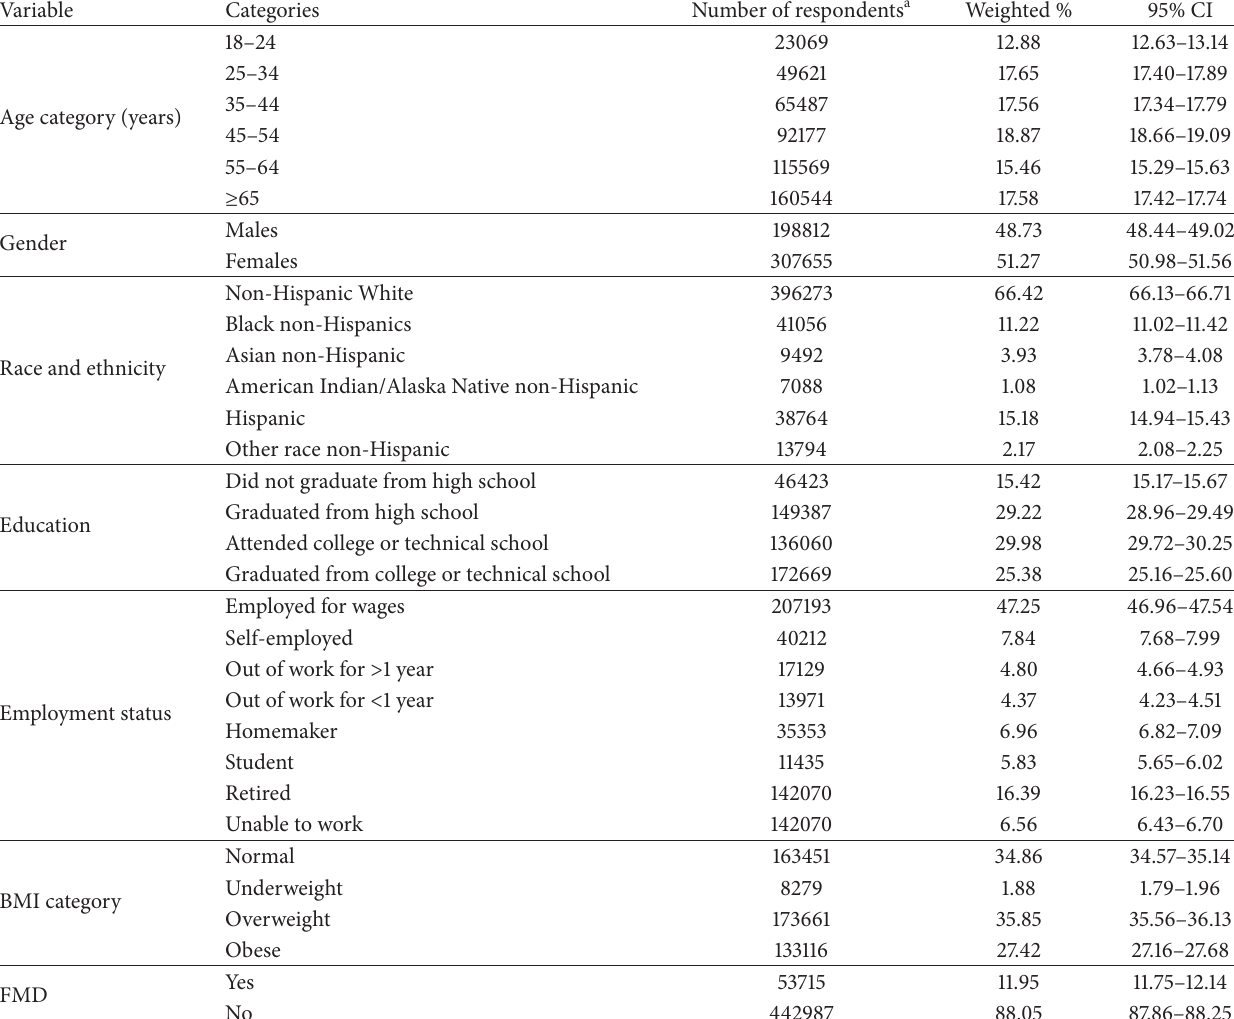
Table 1: Distribution of the sample of adults in the United States, BRFSS 2011 by few sociodemographic factors, BMI, and FMD.